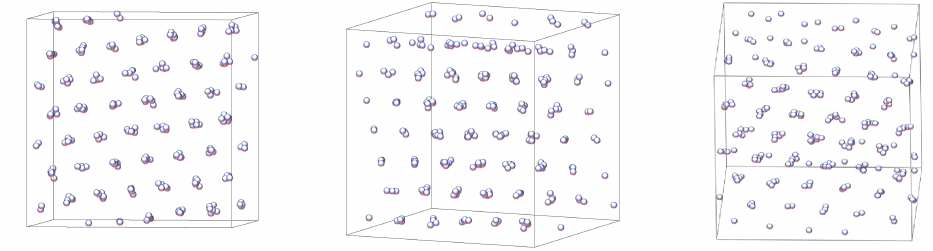
Figure 5. Snapshot of a solid phase at T ∗ = 1.0 and P ∗ = 7.0 from three different angles. To help